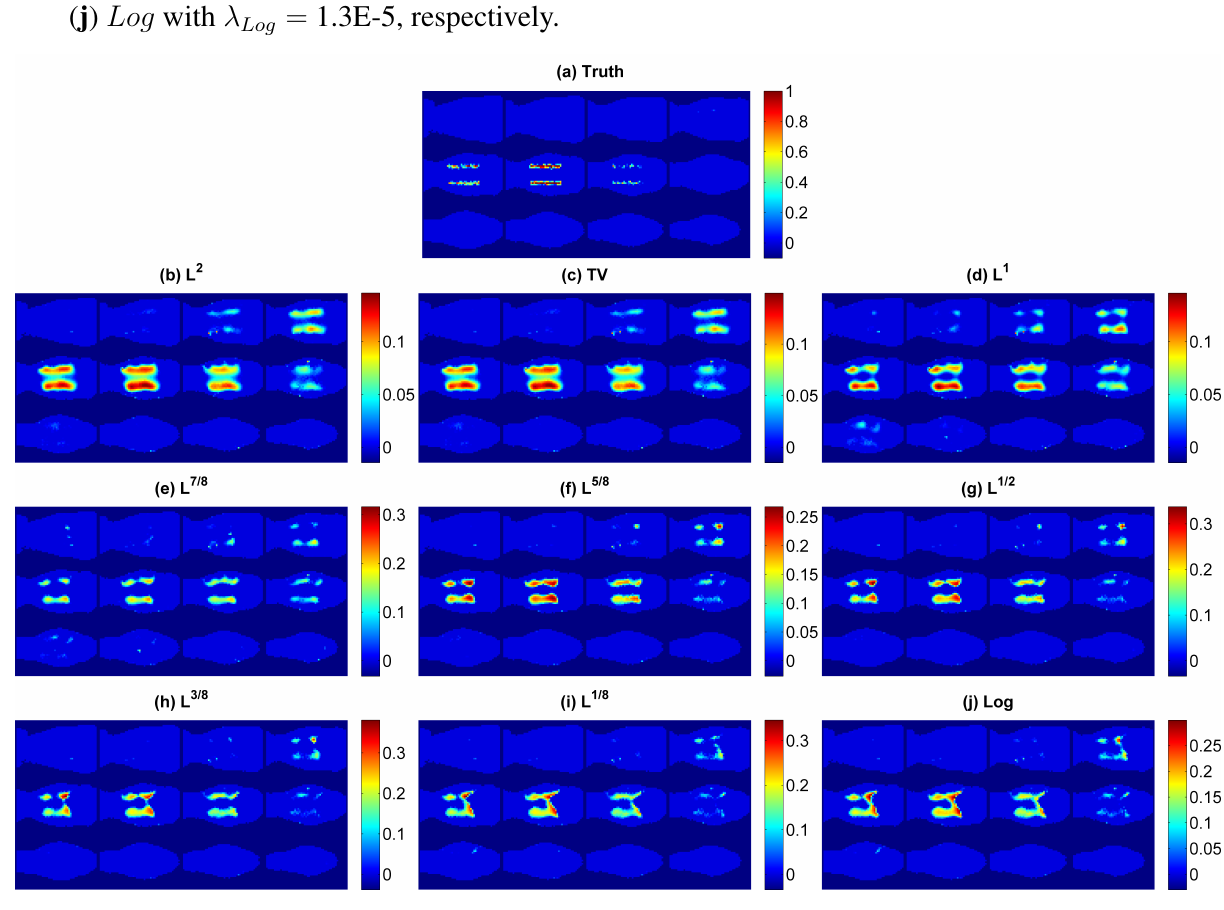
Figure 1. Simulated numerical mouse with two small tubes as targets: coronal sections of the mouse showing ( a ) the simulated truth, and the reconstruction results using = 5.0E-5, ( c ) total variation ( T V ) with λ regularizations based on ( b ) L 2 with λ 2 = 5.9E-4, ( e ) L 7 / 8 with λ = 6.0E-4, ( f ) L 5 / 8 with λ 1.0E-11, ( d ) L 1 with λ 1 7 / 8 = 6.4E-5, ( h ) L 3 / 8 with λ = 3.0E-5, ( i ) L 1 / 8 with λ ( g ) L 1 / 2 with λ 1 / 2 3 / 8 = 1.3E-5, respectively. ( j ) Log with λ Log